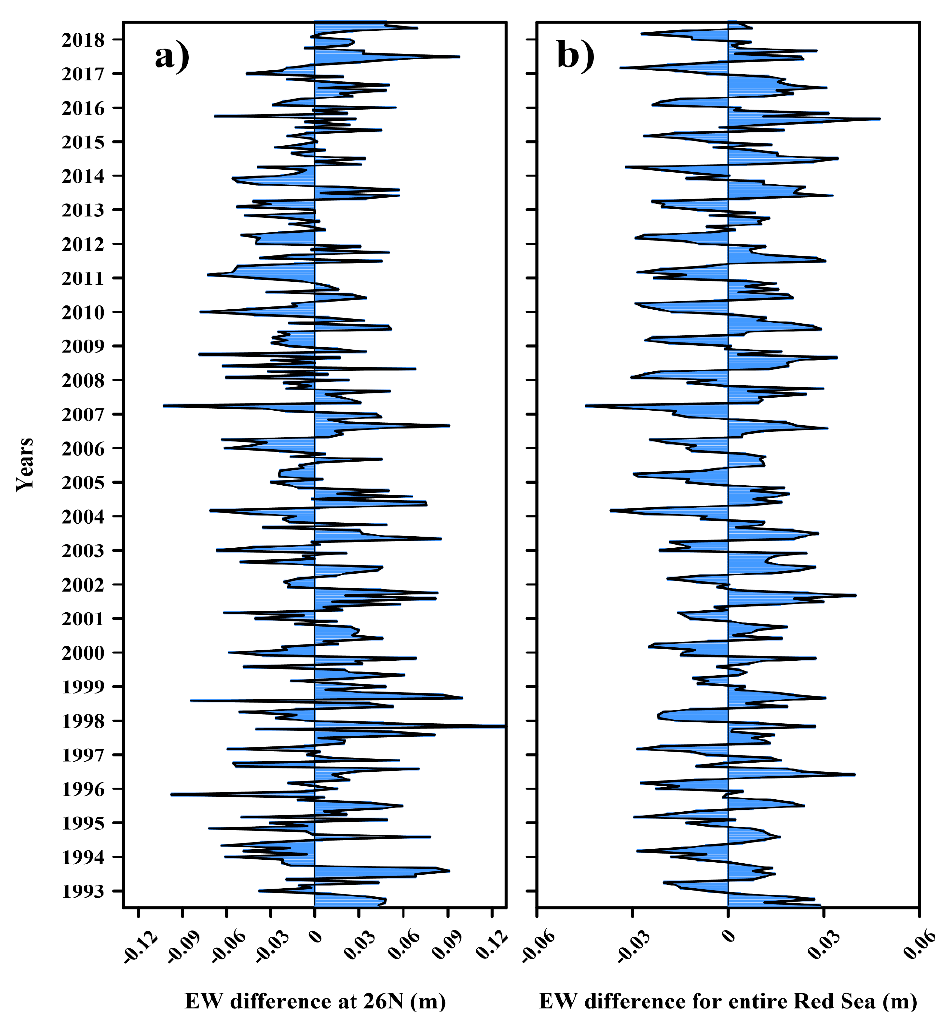
Figure 2. ( a ) The monthly mean eastern–western (EW) difference between the most easterly and most westerly grid points at 26°N (longitude values are 36.625°E and 34.375°E respectively). ( b ) The westerly grid points at 26 ◦ N (longitude values are 36.625 ◦ E and 34.375 ◦ E respectively). ( b ) The monthly monthly mean EW difference between the eastern and the western half of the Red Sea. mean EW di ff erence between the eastern and the western half of the Red